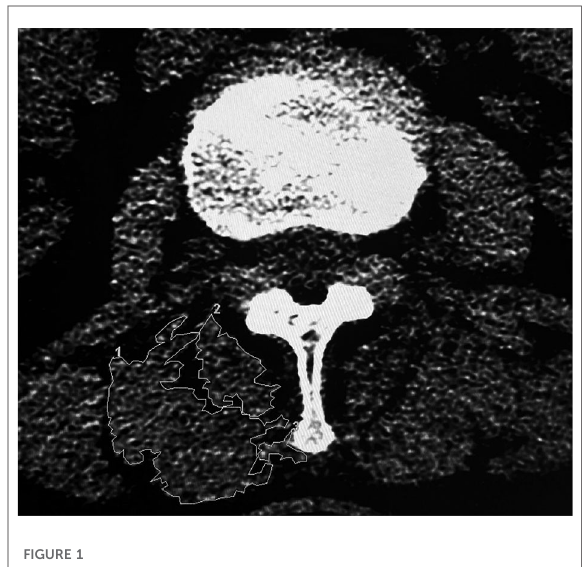
FIGURE 1 Measurement of the MF FCSA in an atrophied muscle.